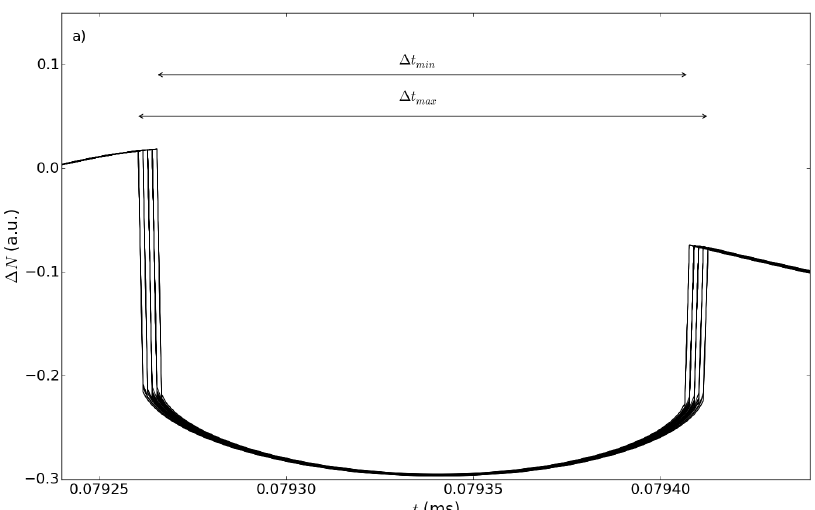
= 10 MHz. Figure 9. Broadening of the temporal trace ∆ N ( t ) for a linewidth ∆ ω QCL The plot focuses on the time lapse between two consequent sub-features, showing the maximum ( ∆ t ) and the minimum ( ∆ t ) values of ∆ t considered in the evaluation max min of the uncertainty σ . The other parameters are as in Figure 3. S,lw